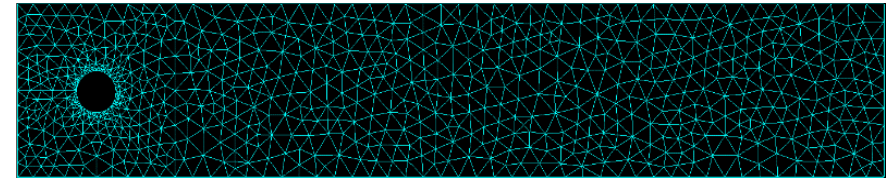
Figure 4. Mesh sample of domain created by the ADINA system.